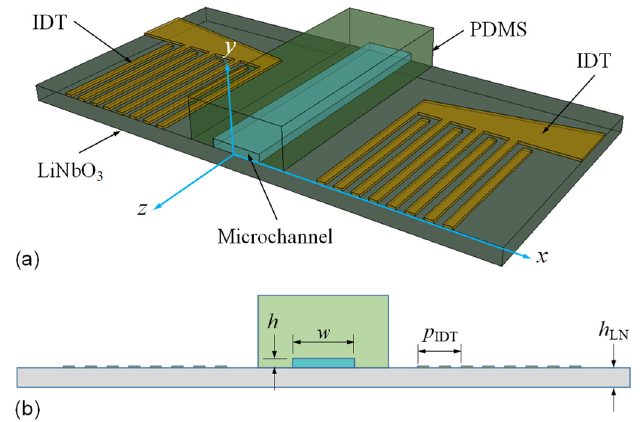
Figure 1. ( a ) Schematics of the sectioned structure and ( b ) the full cross-sectional model of the Lamb-wave acoustofluidic device with a rectangular water channel enclosed in PDMS. The device substrate is a 128° Y-X LiNbO 3 plate with a thickness h LN , and two sets of IDTs having periodic electrode configurations are deposited on its top surface.